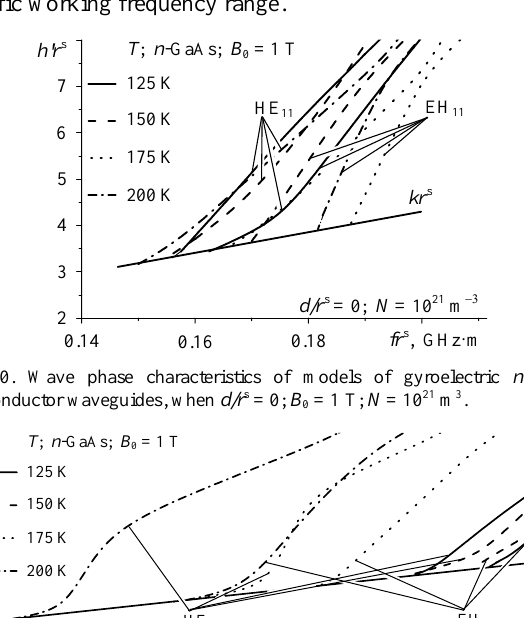
0 0 . 080 . 100 . 120 . 140 . 16 Fig. 11. Wave phase characteristics of models of gyroelectric n -GaAs semiconductor-dielectric waveguides, when d/r s = 0.3; B 0 = 1 T; N = 10 21 m –3 .